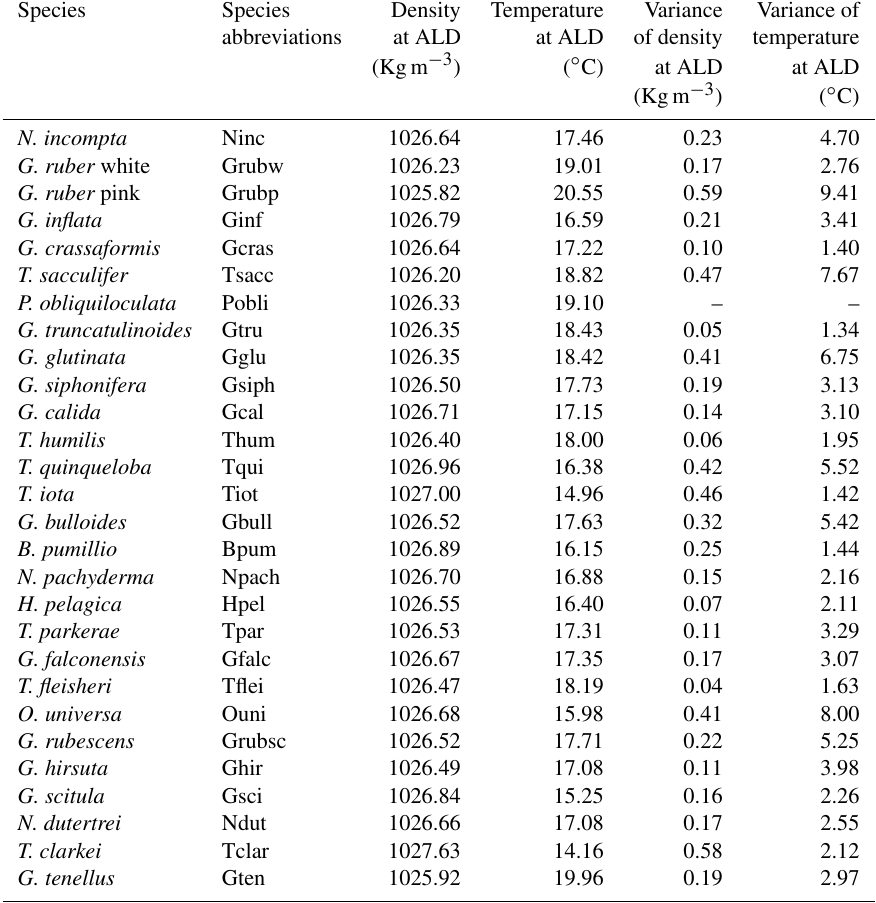
Table 5. Seawater density and temperature at ALD and respective variance for the 28 most abundant species. The abbreviations for each species are also